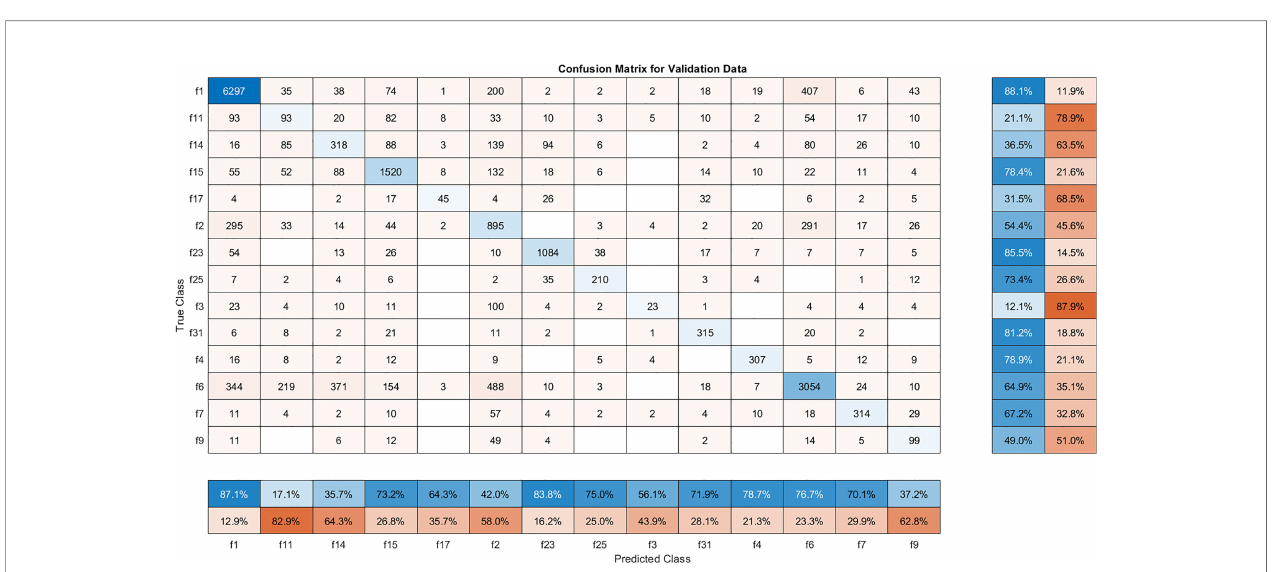
FIGURE 4 | Confusion matrix resulting from the second classi fi cation experiment (30%-70% training/test partition). The two columns on the right of the confusion matrix represent the recall (blue) and the False Negative Rate (orange), respectively; the two rows below the confusion matrix represent the precision (blue) and the False Discovery Rate (orange),